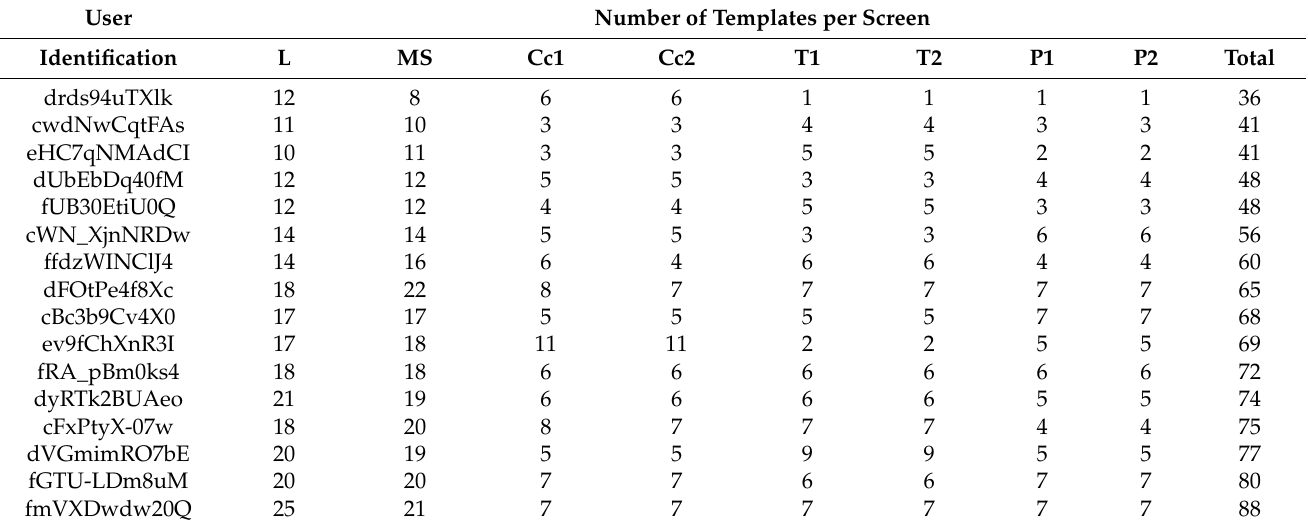
Table 5. Number of templates of the 25 legitimate users participating in the experiment.